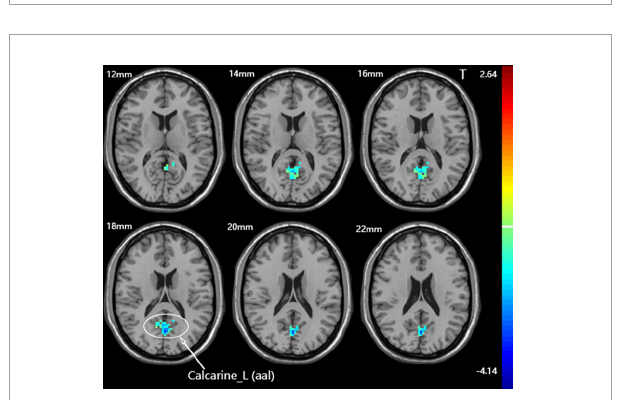
FIGURE5 Statistical maps showing fALFF difference after iTBS between the dominant cerebellum group and the sham group. Warm colors showing fALFF increased and cool colors showing fALFF